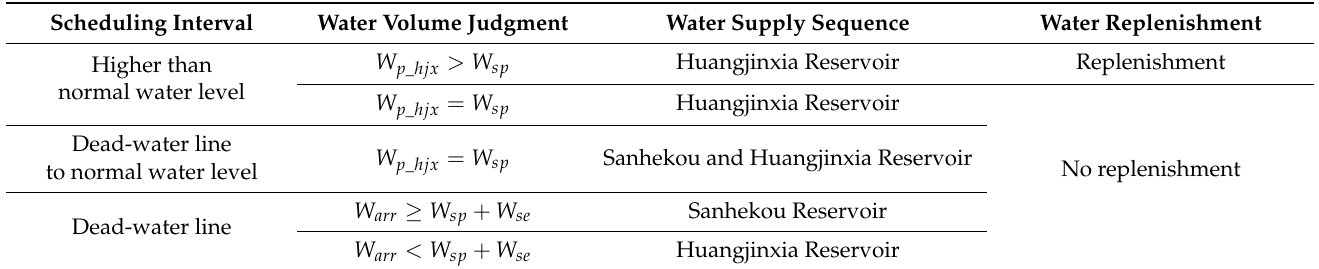
Table 2. Huangjinxia Reservoir dispatching